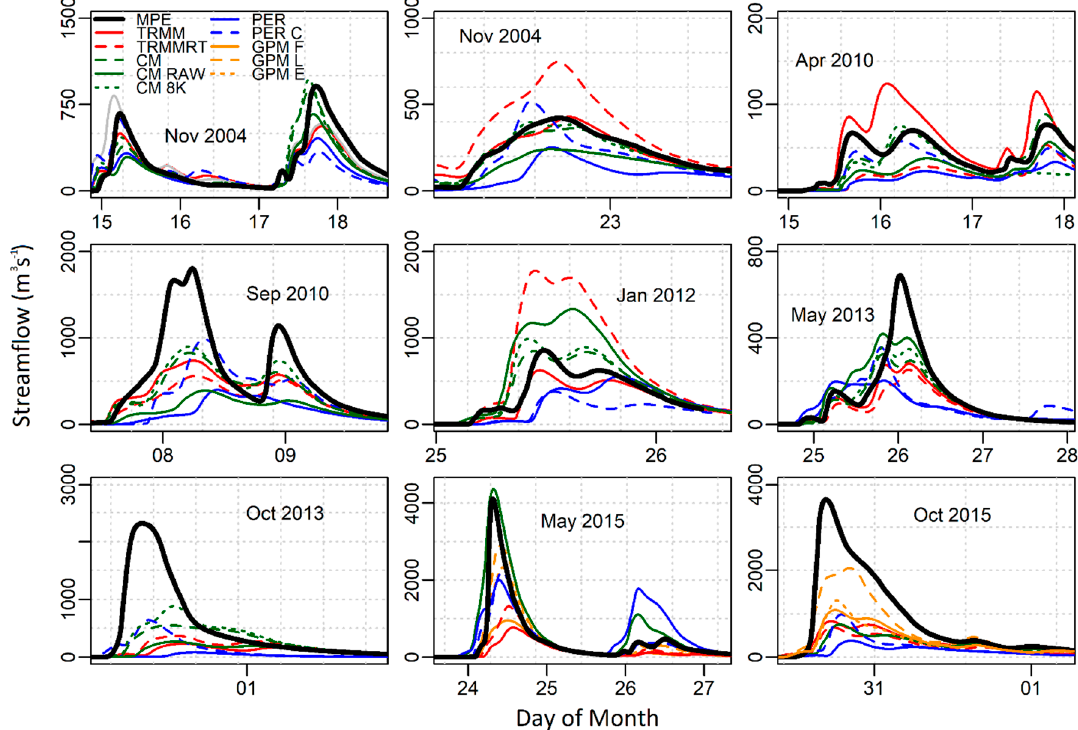
Figure 6. Streamflow hydrographs at the Blanco watershed outlet. Legend labels are abbreviated as follows: MPE—Stage IV, TRMM—TRMM 3B42, CM—CMORPH CDR, GPM F—GPM IMERG FINAL, CM 8K—CMORPH 8KM, PER C—PERSIANN CCS, GPM E—GPM IMERG EARLY, GPM L—GPM IMERG LATE, CM RAW—CMORPH RAW, TRMM-RT—TRMM-RT 3B42, and